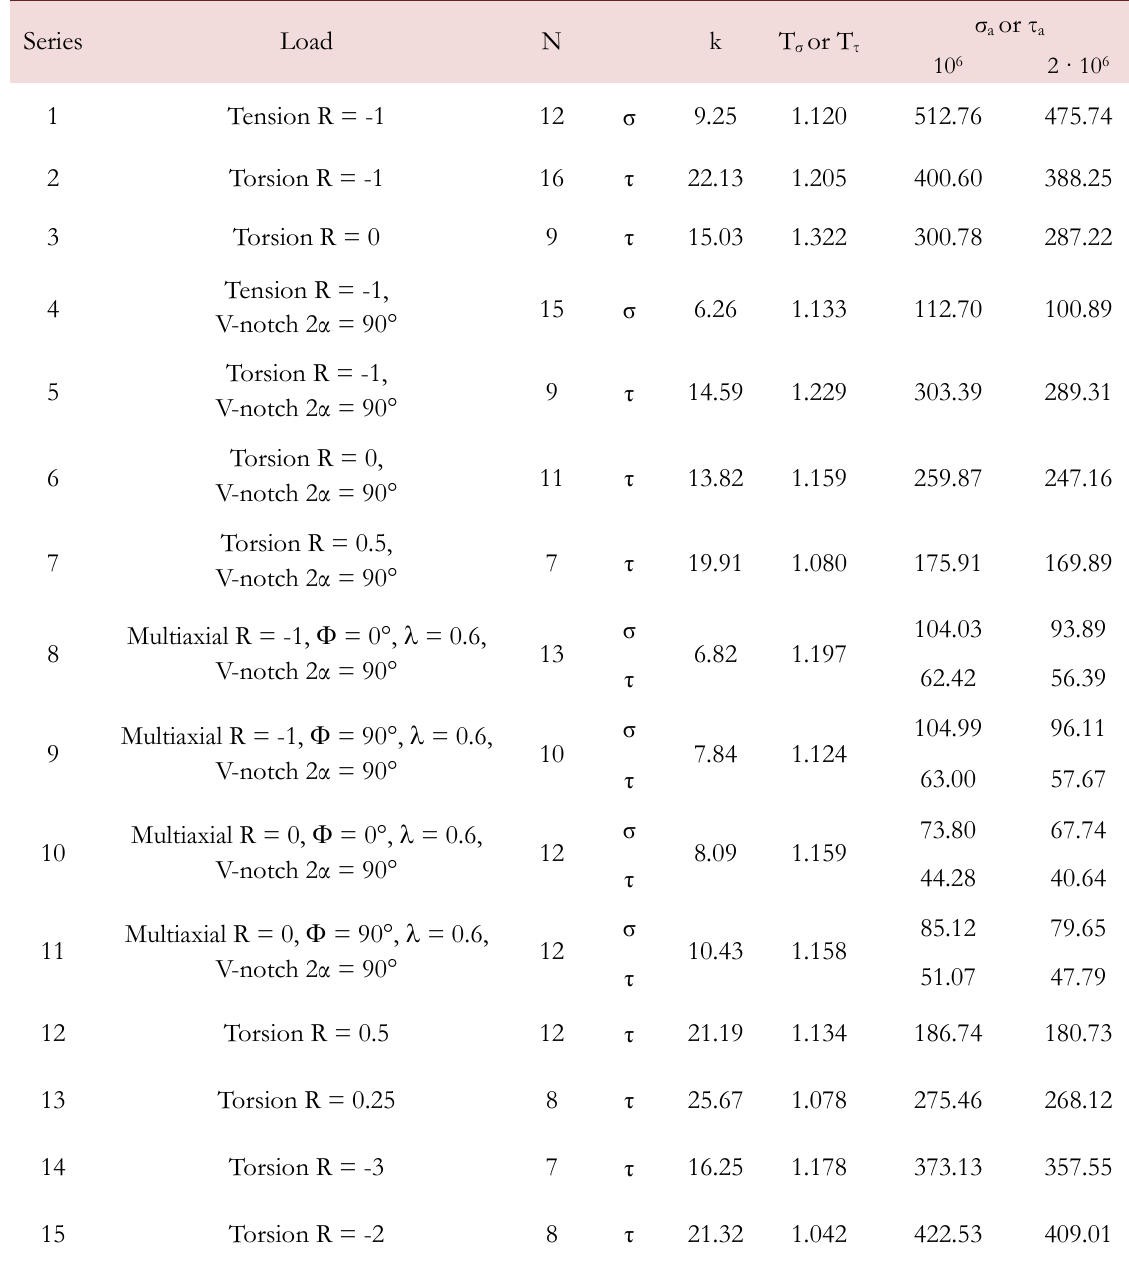
Table 1: Results from fatigue tests. Mean values, P s =50%. Stresses referred to the net